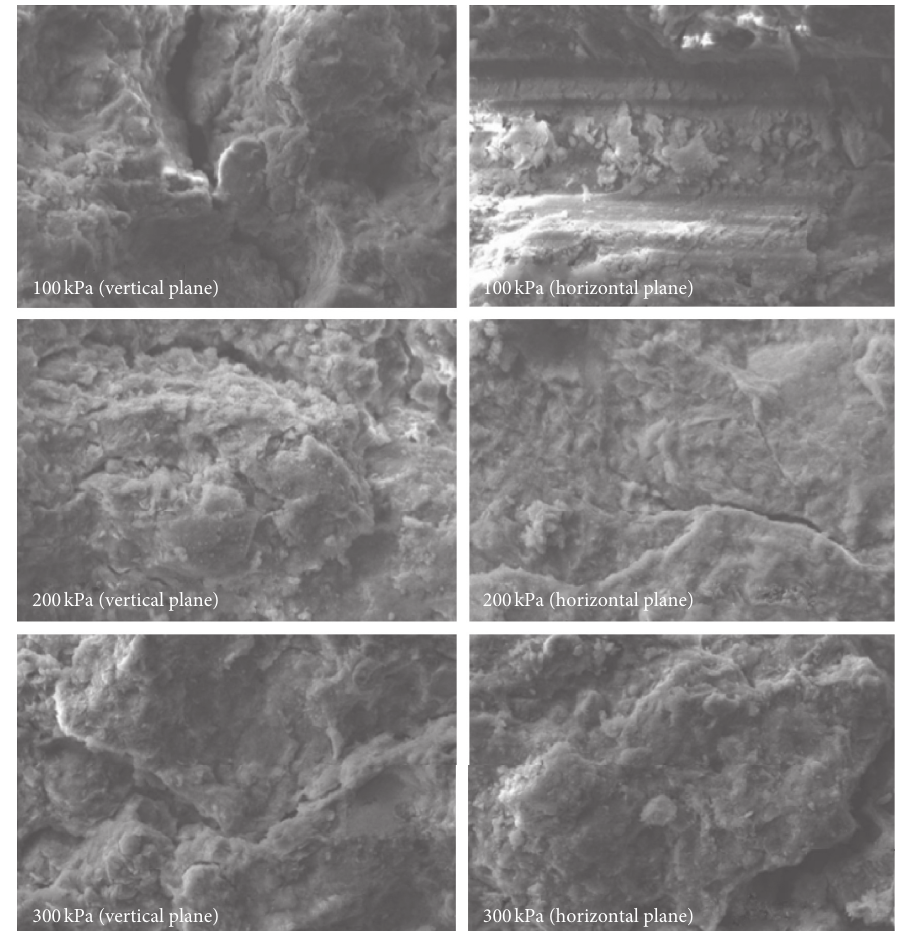
Figure 19: Images of triaxial test failure samples of red clay magnified 500 × under different confining pressures.